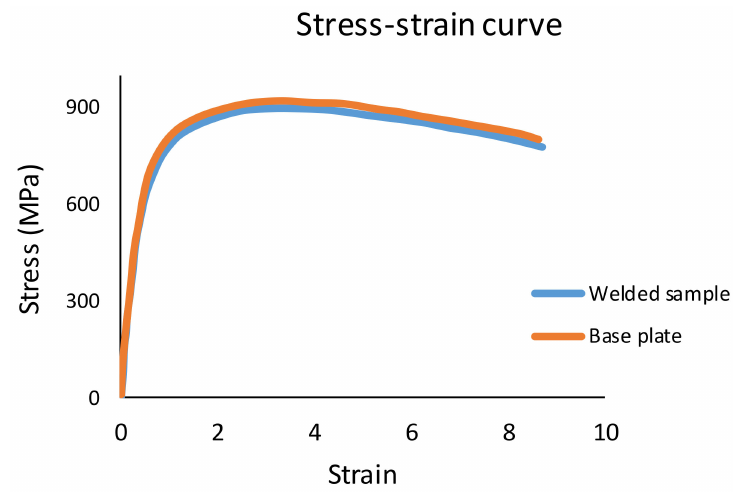
Figure 8. Stress-strain curves upon tensile testing: for the base 16MnCr5 material and for the welded 16MnCr5-41Cr4